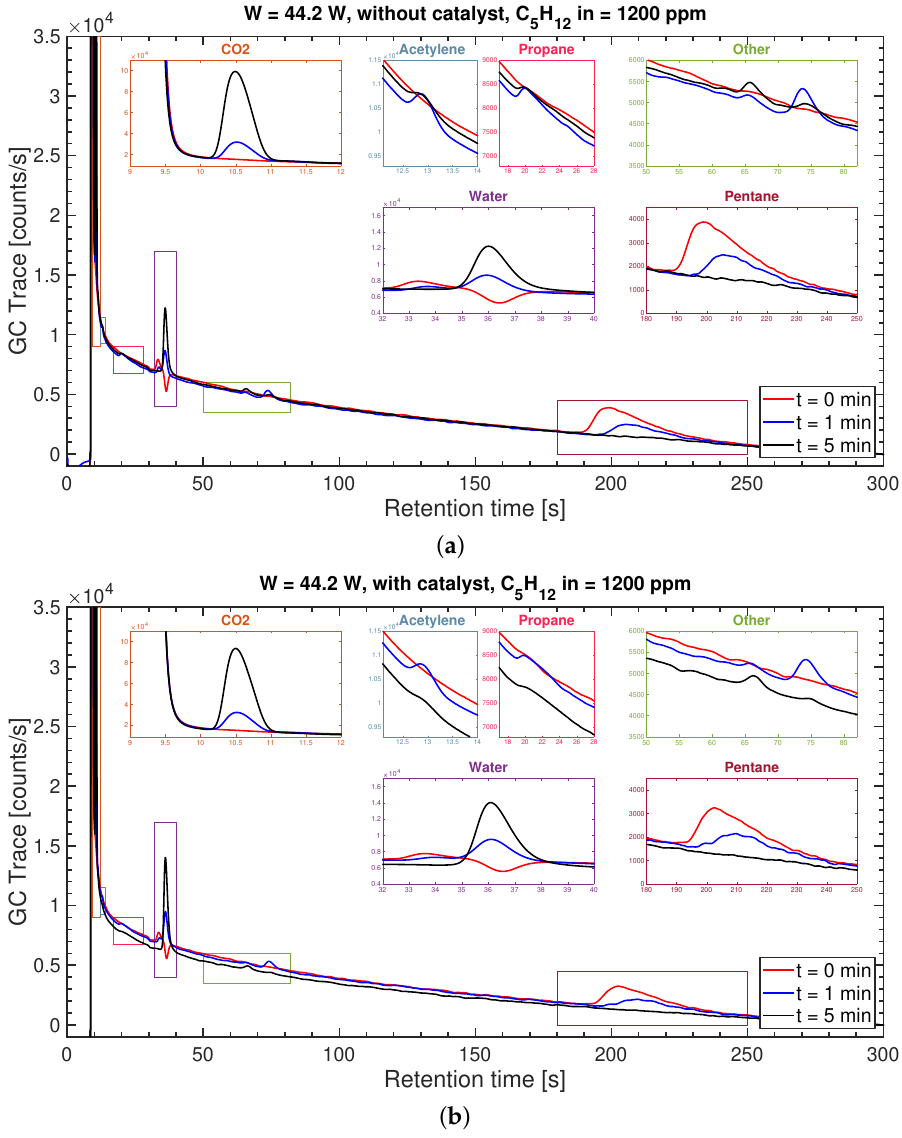
Figure 4. Gas chromatograms vs. retention time [s]. The shown traces correspond to pentane and intermediate products, for treatment times t = 0, 1, 5 min; the plasma lit up at 44.2W, and initial pentane concentration was at 1200ppm. ( a ) Without catalyst. ( b ) With catalyst. The duration of a gas chromatogram is 300s. The insets show the traces for the intermediate reaction products (CO 2 , acetylene, propane, water, and other unidentified species) and